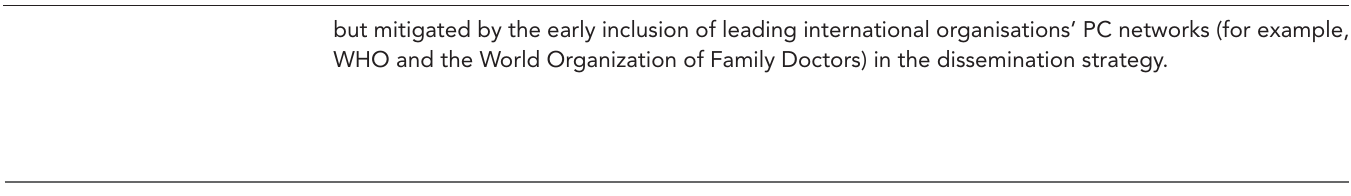
Figure 5 Responses on movement restriction at time of first mortality for 38 countries from highest (Belgium) to lowest (Fiji) mortality